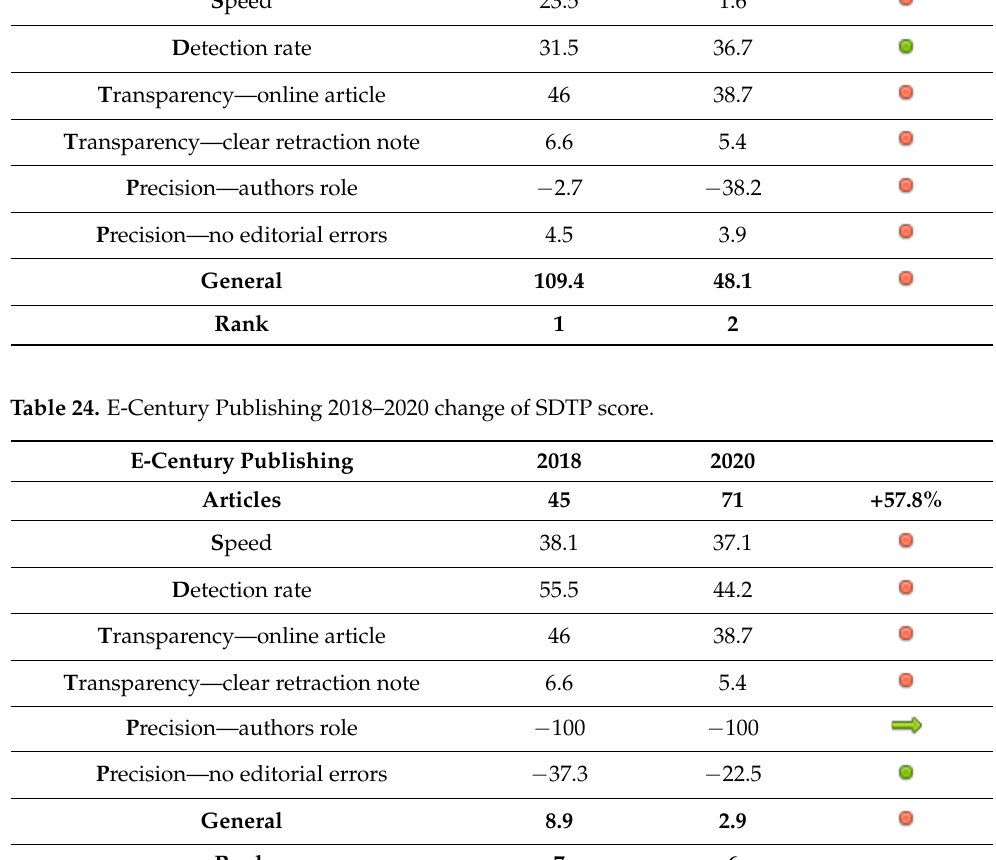
Table 15. Elsevier 2018 – 2020 change of SDTP score. Table 16. Springer Nature 2018 – 2020 change of SDTP score.